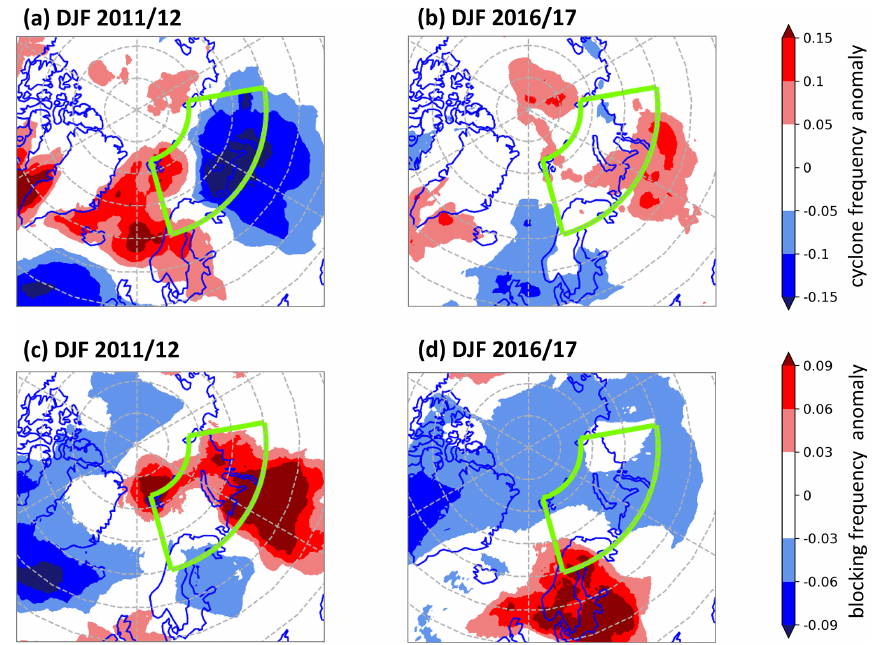
Figure 12. Seasonal-mean (a, b) cyclone frequency and (c, d) blocking frequency anomalies for (a, c) DJF 2011/12 and (b, d) DJF 2016/17. Region of the Kara and Barents seas is marked with green